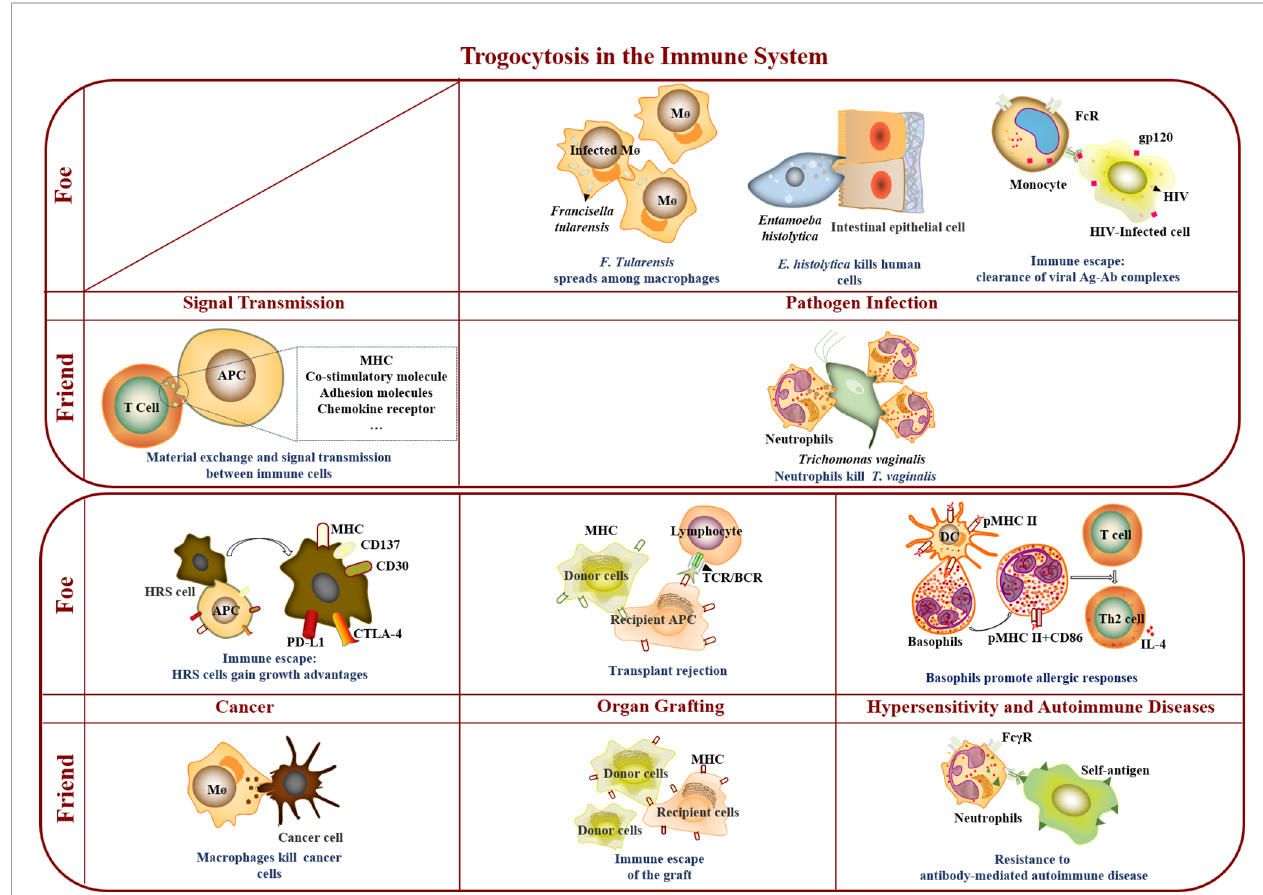
FIGURE 1 | Trogocytosis in the immune system. In the immune system, trogocytosis mediates material exchange and signal transmission between immune cells, participates in immune cell killing of T. vaginalis and tumor cells, assists immune escape of grafts, and promotes resistance to antibody-mediated autoimmune disease. As a foe, trogocytosis accelerated F. Tularensis spreading among macrophages, and was involved in E. histolytica killing human cells, immune escape of virus and tumor cells, transplant rejection, and promotion of allergic